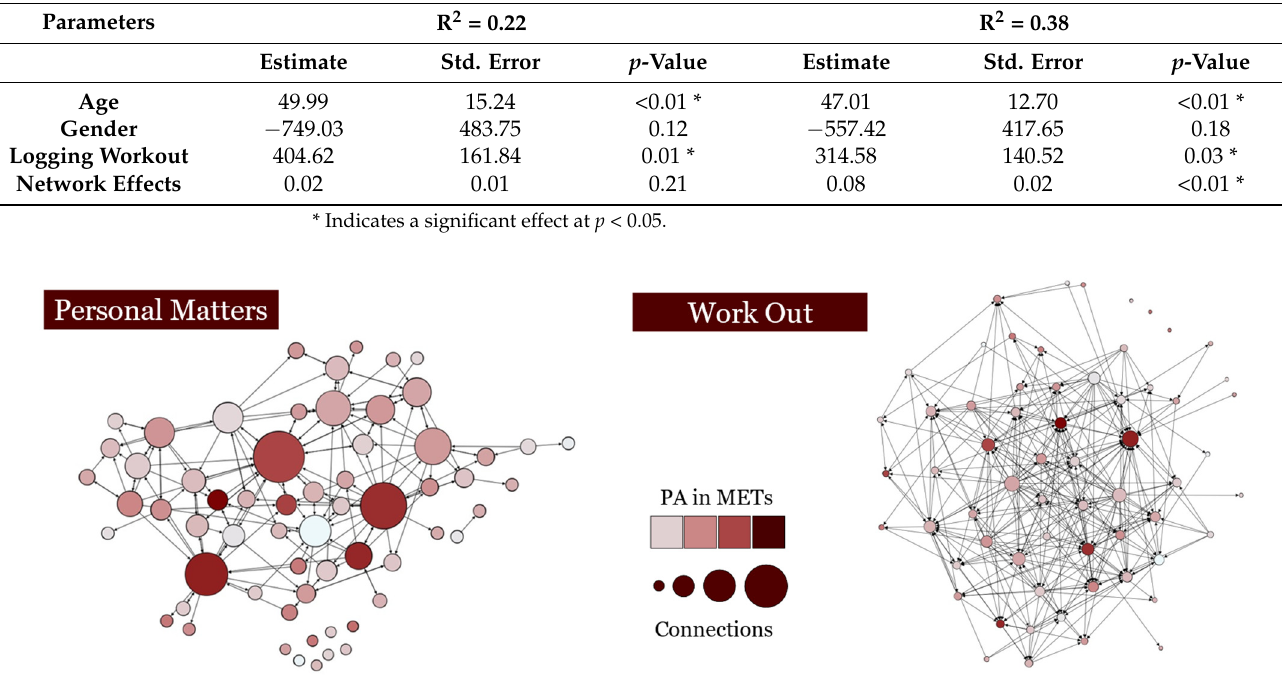
Figure 1. Personal matters and work out networks displayed. Note: nodes are sized by the number of connections in each network and colored by the amount of reported physical activity.